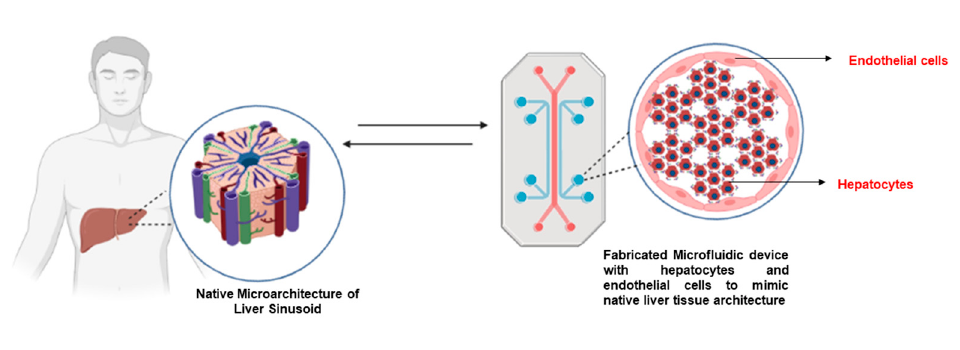
Figure 4. Schematic representation of a liver-on-chip device to mimic the native liver tissue microar- chitecture. Original images by authors created with Biorender.com (accessed on 20 October 2022). Table 1. Studies that have used liver-on-chip configurations with shear stress to mimic the native liver sinusoid enlisted. (PSC-Pluripotent Stem